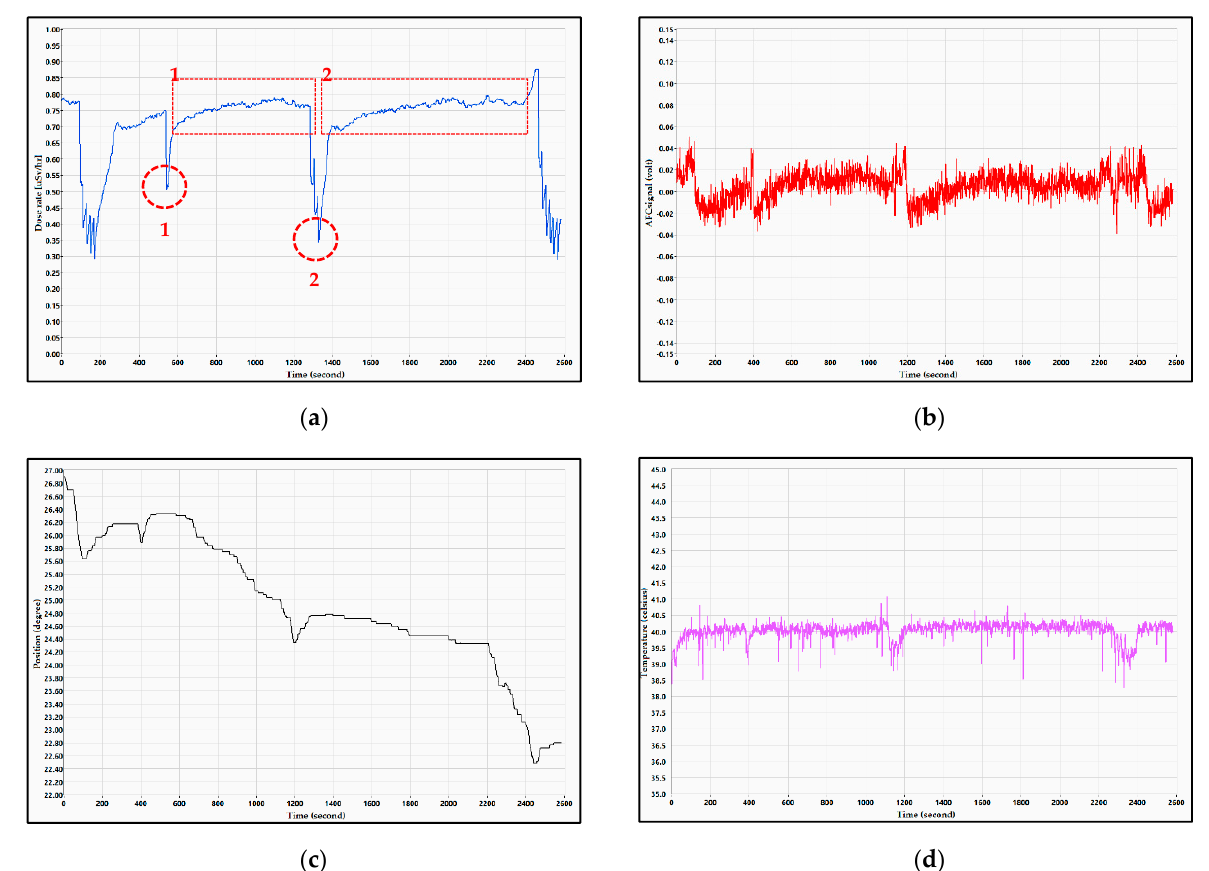
Figure 21. The fuzzy system response: ( a ) X-ray response; ( b ) AFC signal response; ( c ) Motor position response; ( d ) Temper- ature